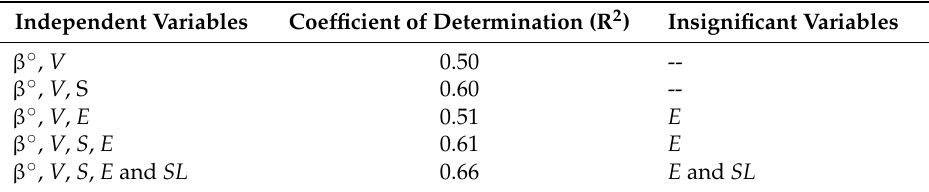
Table 2. Coefficient of determination (R 2 ) values of multiple linear regression based models. Independent Variables Coefficient of Determination (R 2 ) Insignificant Variables β ˝ , V 0.50 -- β ˝ , V , S 0.60 -- β ˝ , V , E 0.51 E β ˝ , V , S , E 0.61 E β ˝ , V , S , E and SL 0.66 E and